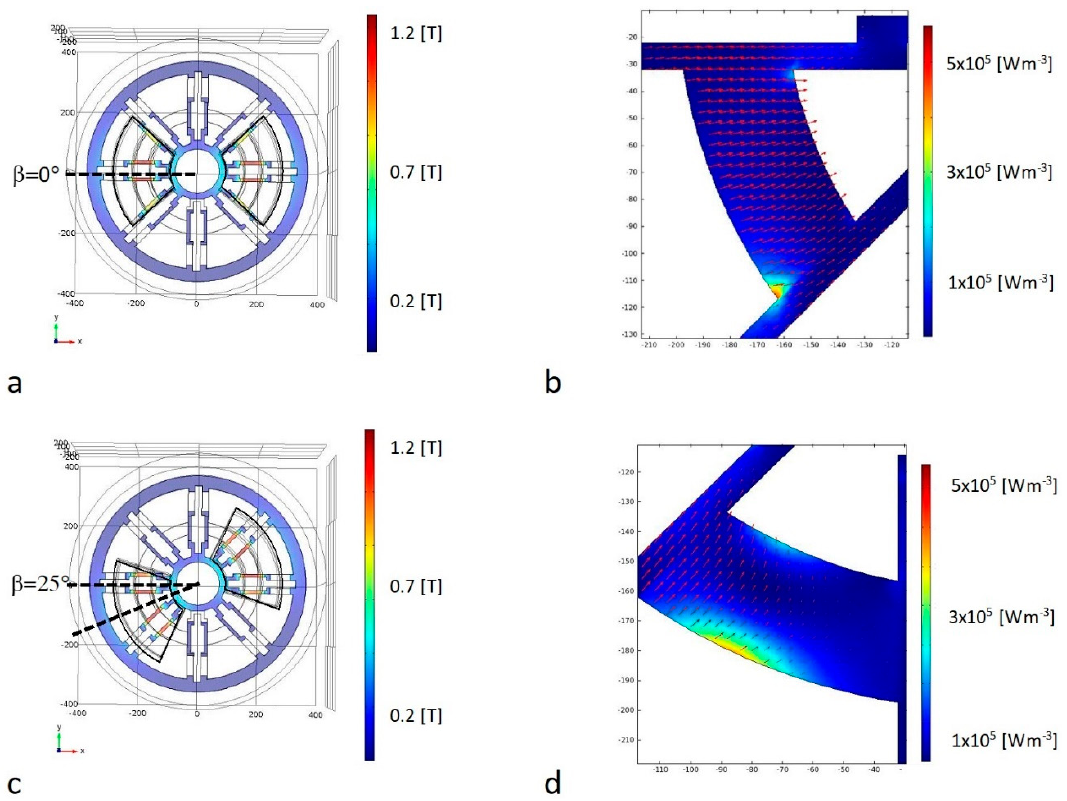
Figure 5. Magnetic flux distribution ( a – c ), induced current density ( b – d ), and resistive losses ( b – d ) for two different positions of the magnets.